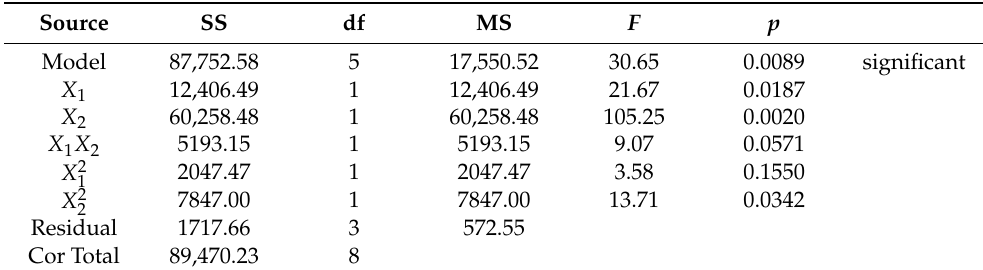
Table 5. Analysis of variance (ANOVA) test for quadratic model of equilibrium swelling of the p(NIPAM-co-AA)